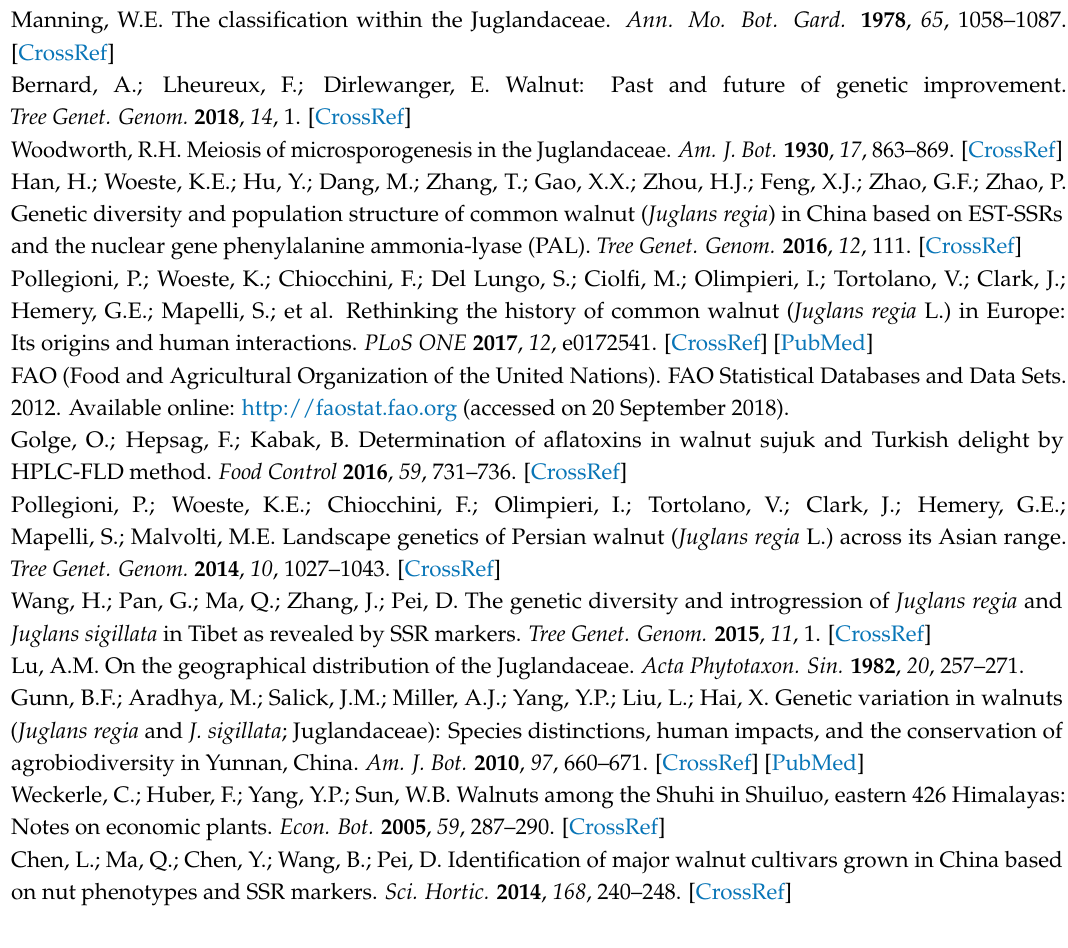
generated by UPGMA cluster analysis of 506 individuals of J. regia and J. sigillata and (b) NJ cluster analysis of 28 Juglans populations based on Nei’s unbiased genetic distances. The letter of “s” at the end of population names means J. sigillata and “r” means J. regia . (c) Principal coordinates analysis ( PCoA ) of 28 populations from J. regia and J. sigillata based on EST-SSR (25 loci); each walnut species is labeled with two different colors, representing 506 individuals that were grouped into two clusters. Figure S6. BARRIER analyses of the main genetic barriers of Juglans regia . Delaunay triangulation and detected barriers with bootstrap values over 1000 replicates using Nei’s genetic distances. Blue line represents delaunay triangulation, red line indicates statistically significant genetic boundaries. Figure S7. BARRIER analyses of the main genetic barriers of Juglans sigillata . Delaunay triangulation and detected barriers with bootstrap values over 1000 replicates using Nei’s genetic distances. Blue line represents delaunay triangulation, red line indicates statistically significant genetic boundaries. Table S1. Number of samples (N), location, geographic coordinates (latitude and longitude) for 28 Juglans populations surveyed in southwestern China. Table S2. Percentage of variation explained by the first 3 axes using Principal Coordinate analysis for model based approach. Table S3. Description of private alleles by 12 populations. Table S4. Summary of profile likelihood percentiles of all